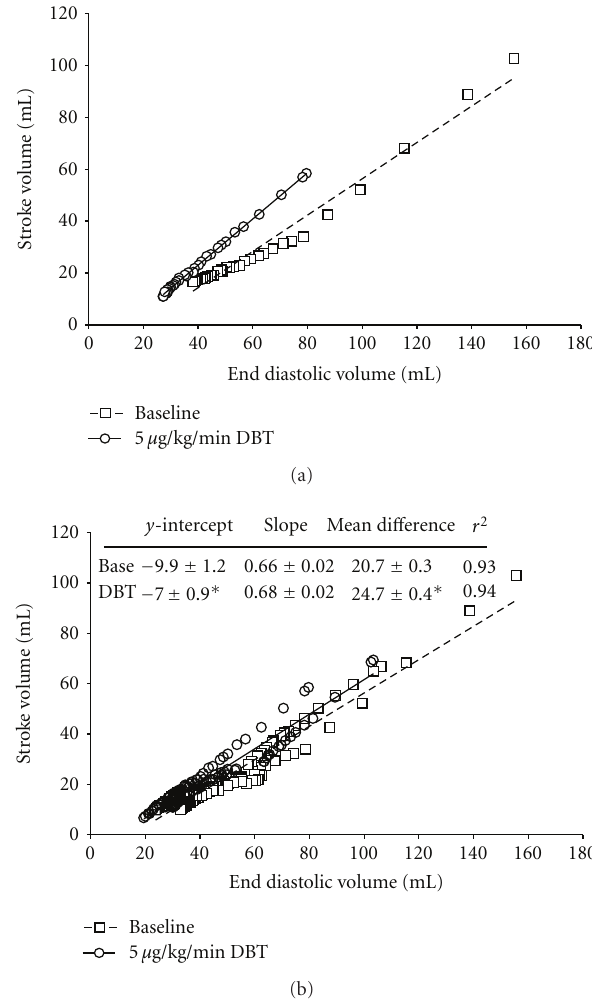
Figure 7: (a) Representative Frank-Starling relationship from one animal at baseline (Base) and after treatment with dobutamine (DBT). (b) Comprehensive group data from all animals illustrating a significant leftward shift in the Frank-Starling relationship (mixed model, treatment main e ff ect adjusted for EDV covariance, P < 0 . 05). There was no significant interaction or change in slope of the Frank-Starling relationship between treatments (see table inset in (b)), therefore, parallelism was assumed. The y -intercept and marginal mean di ff erence were both significantly increased follow- ing the dobutamine treatment ( ∗ P < 0 . 05; table inset (b)). The dobutamine challenge resulted in a ∼ 15% increase in stroke volume (SV) for a given end diastolic volume (EDV) in vivo . This increase in ventricular function was similar in magnitude to that observed in our myocyte preparations ( ∼ 10%), illustrating the coherence of our whole heart and cardiac myocyte functional